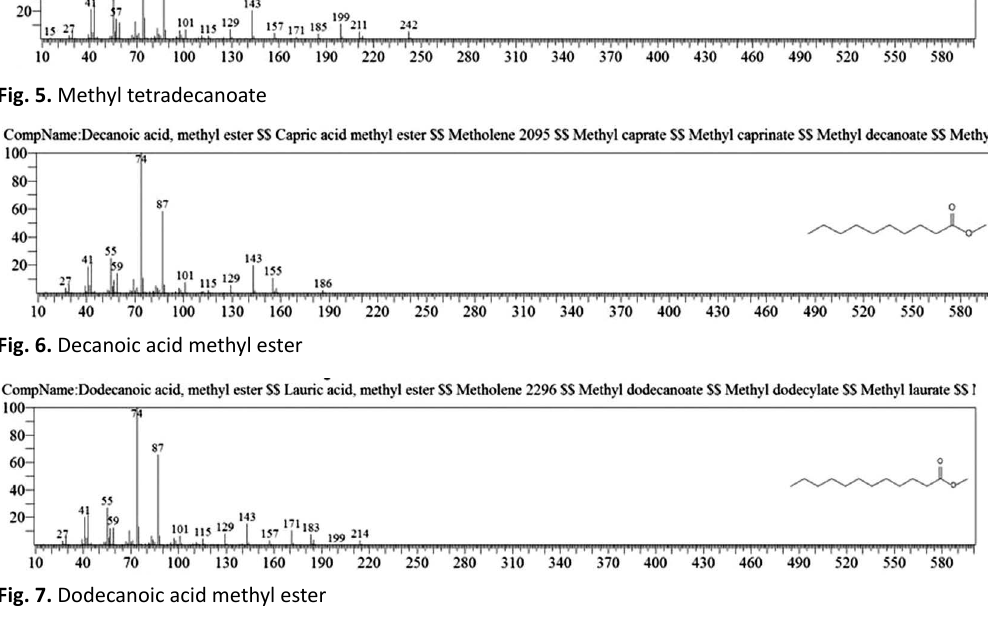
Fig. 7. Dodecanoic acid methyl